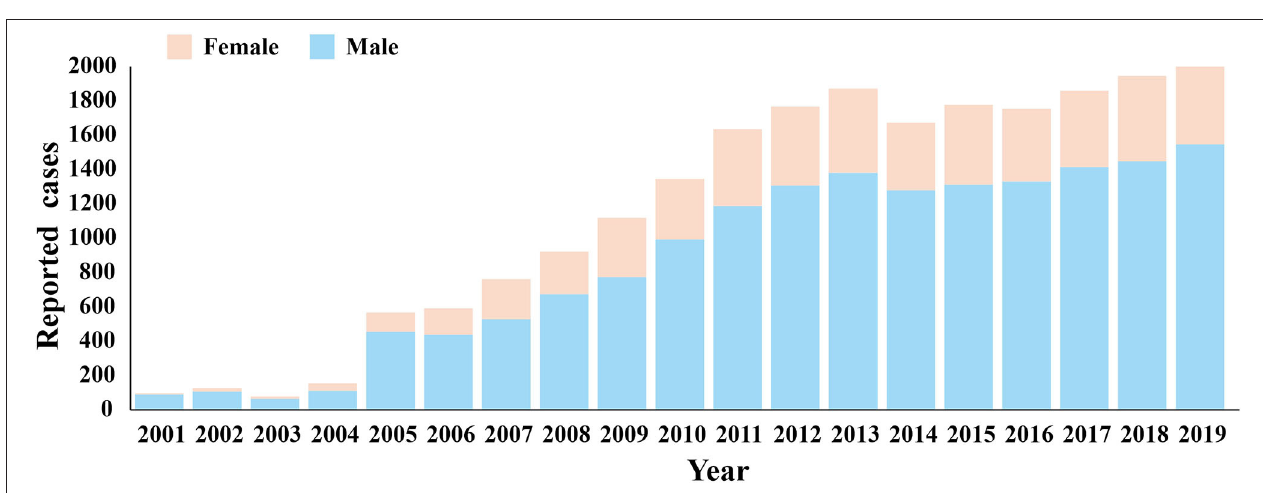
FIGURE 5 | The distribution by sex of HIV in Nanning from 2001 to